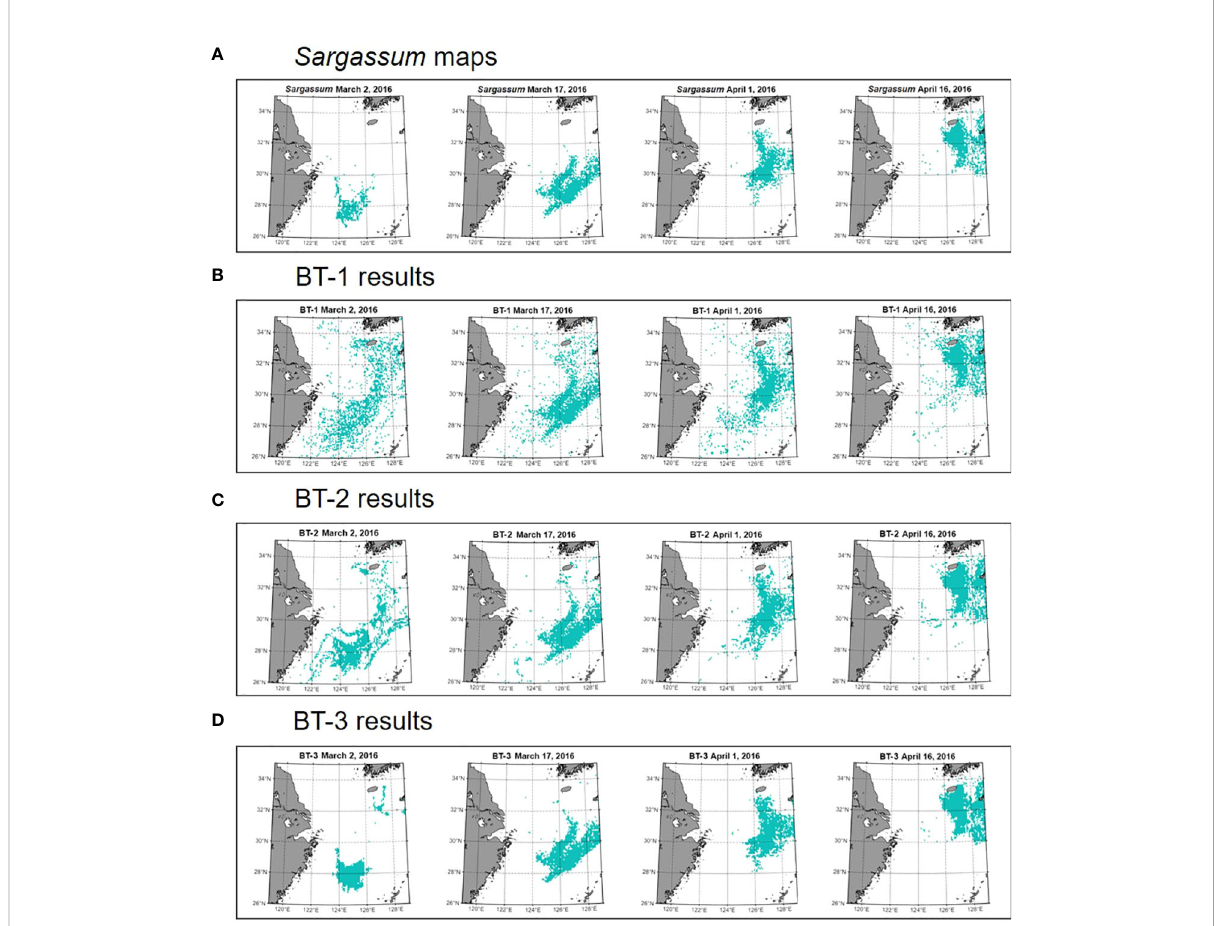
FIGURE 5 Sargassum map as ground truth and estimated maps derived from machine learning models (A) Daily Sargassum map was generated fromparticle tracking model. The estimated Sargassum maps generated from (B) BT-1, (C) BT-2, and (D) BT-3 models. In 2016, Sargassum patches fi rst appeared in the ECS on March 2 and gradually moved toward the Korean Peninsula. The maps are displayed every 15 days since thepatches